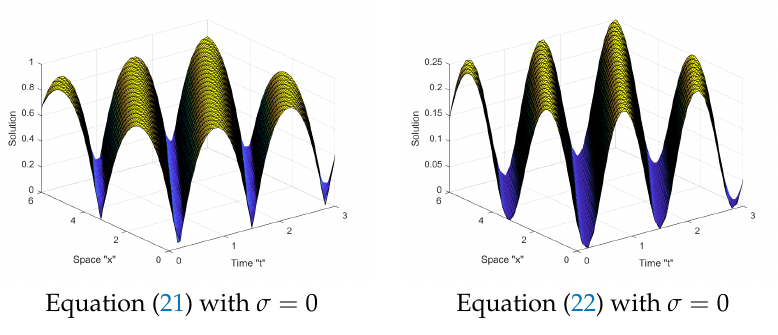
Figure 1. 3D profile of Equations (21) and (22) with σ = 0.